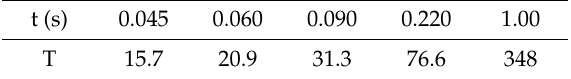
Figure 5. Effects of H/D on the normalized position where the peak velocity is found. From RANS at Re = 20,000. Table 2. Flow time monitored. t is the dimensional time in seconds (s). T is the non-dimensionalised